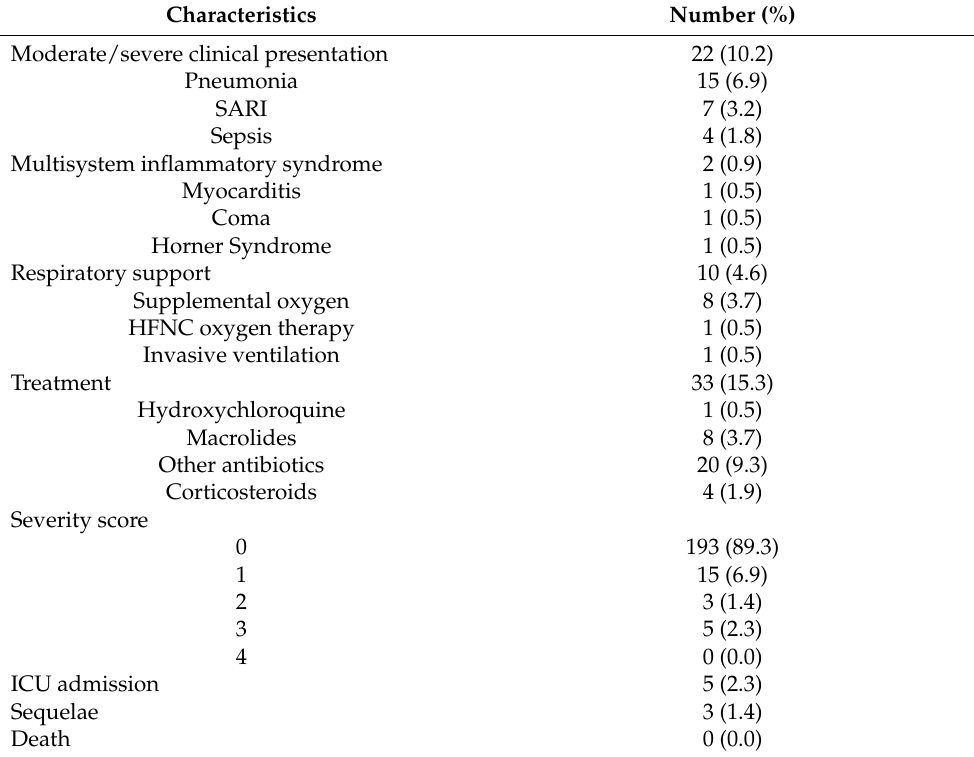
Table 4. Treatment and